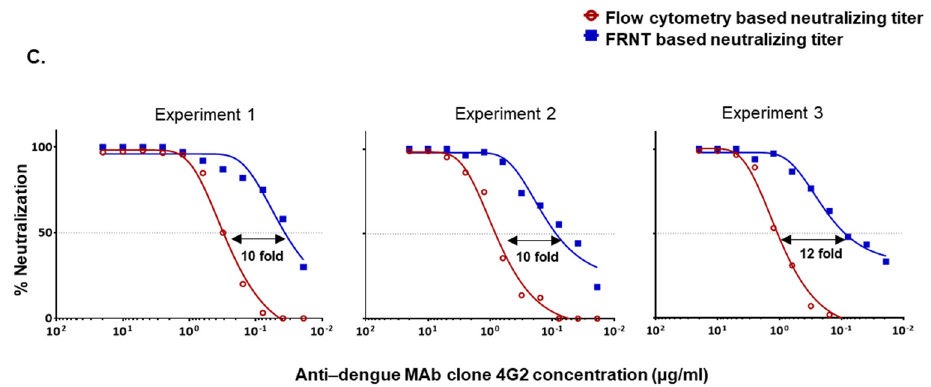
Figure 1. Comparison of neutralization titers obtained by FRNT and flow cytometry based assays using 4G2 monoclonal antibody. ( A ) Raw data on DENV2 neutralization by 4G2 monoclonal antibody in Vero cells using the focus reduction neutralization test (FRNT). Red circles indicate the 50% neutralizing titer (FRNT 50 ). ( B ) Raw data on DENV2 neutralization by 4G2 monoclonal antibody in Vero cells using the flow-based neutralization assay. Red box indicates the approximate dilution at which 50% neutralization occurred. ( C ) The horizontal dotted line plotted over the nonlinear dose–response regression analysis indicates the concentration of 4G2 monoclonal antibody needed to cause 50% reduction of neutralization using the FRNT (blue line) and the flow cytometry-based assay (red line) in three independent experiments using different batches of the 4G2 MAb.